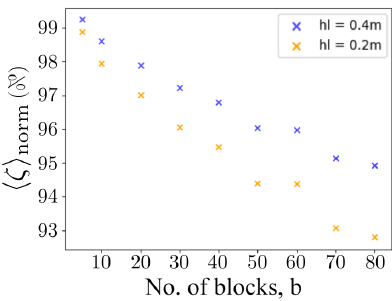
Figure 9. Sensitivity of the average WTD to a difference in the block head level, hl. The values of (cid:104) ζ (b) (cid:105) norm correspond to the optimal block positions computed for hl = 0 . 2m (orange) and hl = 0 . 4m (blue). The larger the blocks are, the higher the WTD has